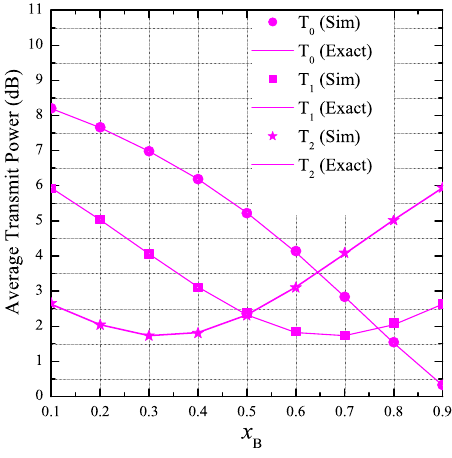
Figure 3. Average transmit power of the secondary transmitters as a function of x B when P S = 10 dB, K = 3, N D = 3, ε = 0.25, η = 0.25, y B = 0.3, x P = 1 − x B , and y P = − 0.5.